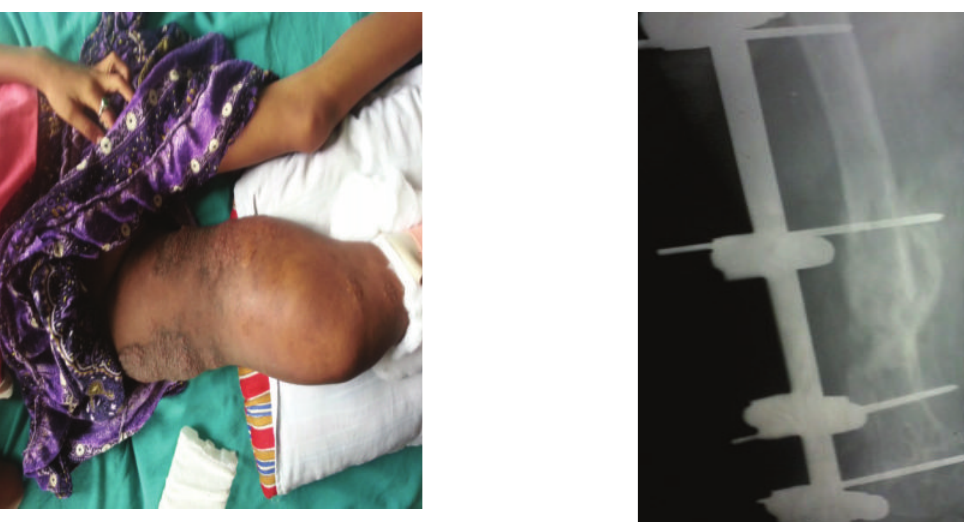
Figure 1: Clinical picture at the time of presentation to emergency department.